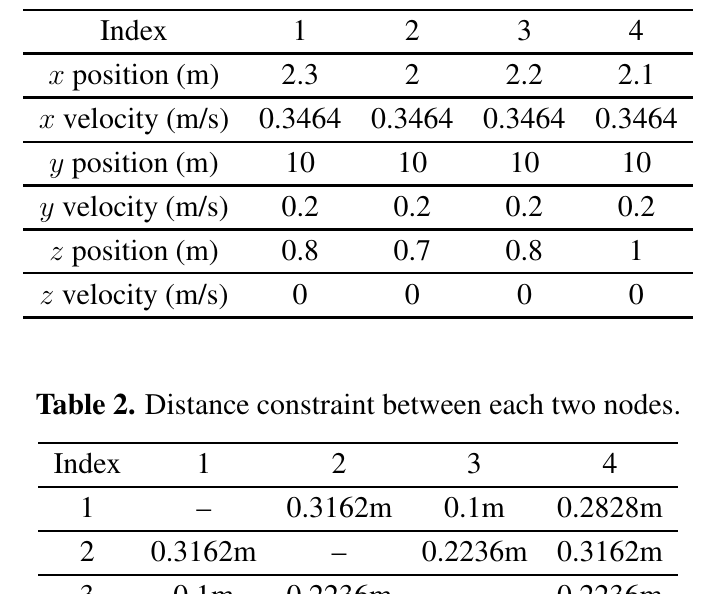
Table 1. Initial positions of the 4 nodes.